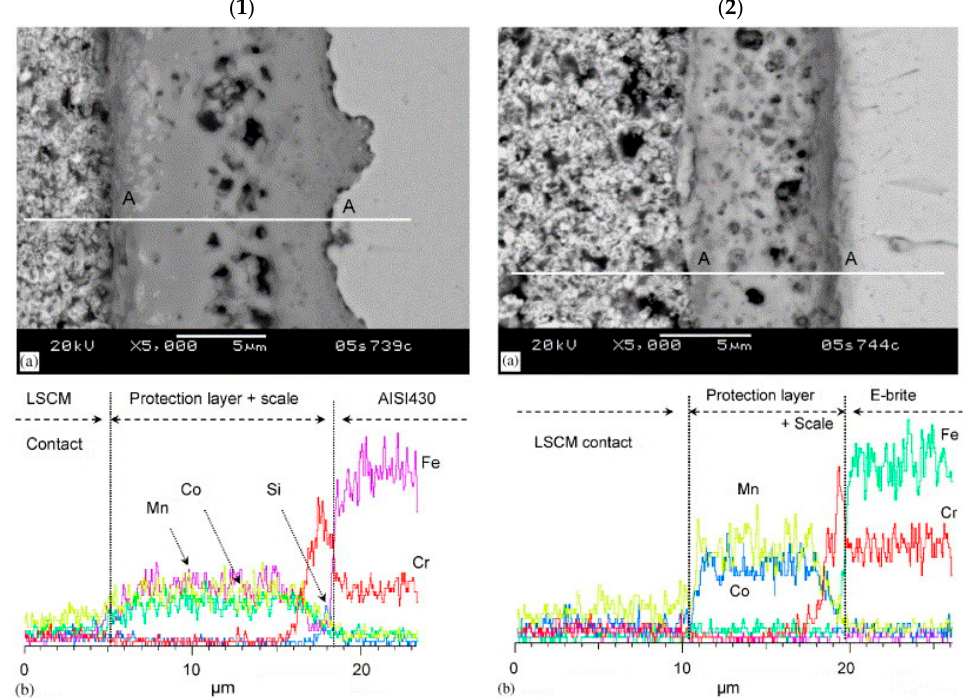
Figure 10. SEM/EDS analysis of: ( 1 ) AISI430 and ( 2 ) E-brite with Mn 1.5 Co 1.5 O 4 protection layer after the contact ASR measurement at 800 °C in air for about 400 h. ( a ) SEM cross-section and ( b ) EDS line scan along line A–A in ( a ), adapted from [49], with permission from Elsevier,